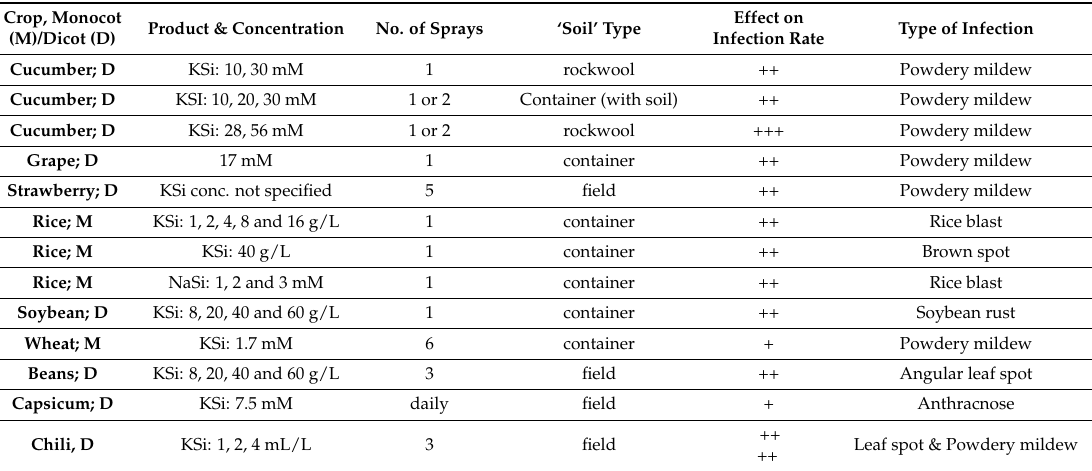
Table 1. Summary of the efficacy of foliar silicates sprays (KSi: potassium silicate; NaSi: sodium silicate) on the infection rate of several common diseases in monocots (M) and dicots (D). In separate columns: product concentration, number of sprays, specification of the soil/substrate type, the effect on infection rate and type of infection are mentioned. The reduction in the infection rate is specified as: + moderate (<30%), ++ good (30–70%) and +++ very good (>70%). The concentration of the KSi in the study on strawberry plants was not